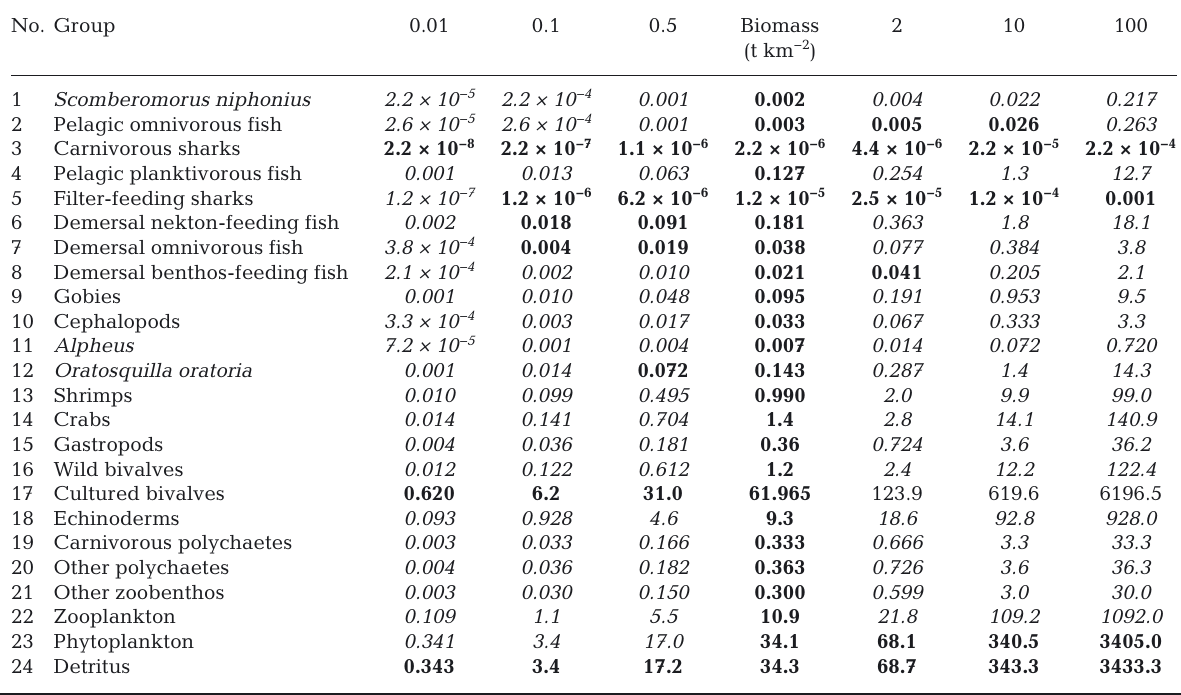
Table 4. Robustness of biomass values at the ecological carrying capacity of cultured bivalves in the Yellow River Estuary ecoregion. For each group, biomass values were multiplied by factors of 0.01, 0.1, 0.5, 2, 10 and 100; only one value was changed at a time with all other biomass values remaining constant. Bold numbers indicate that the model remained balanced despite the changes, representing high robustness of those groups at the carrying capacity of cultured bivalves. Numbers in italics indicate that the model became unbalanced, indicating low